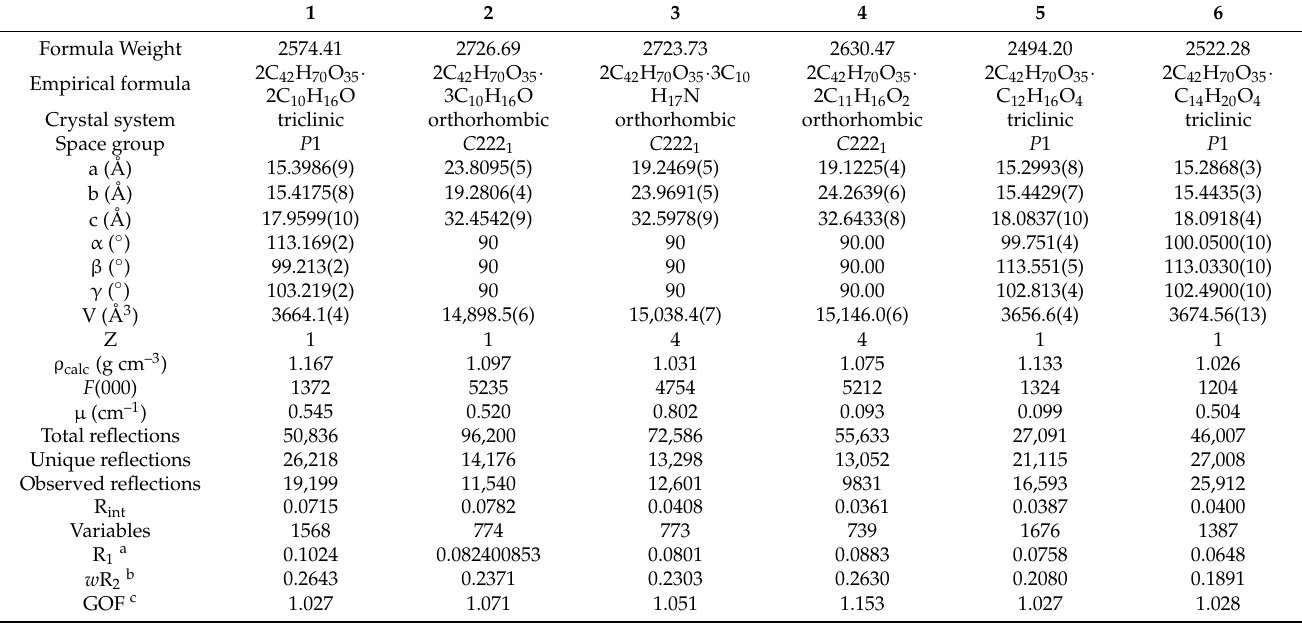
Table 1. Crystal data and refinement parameters for the